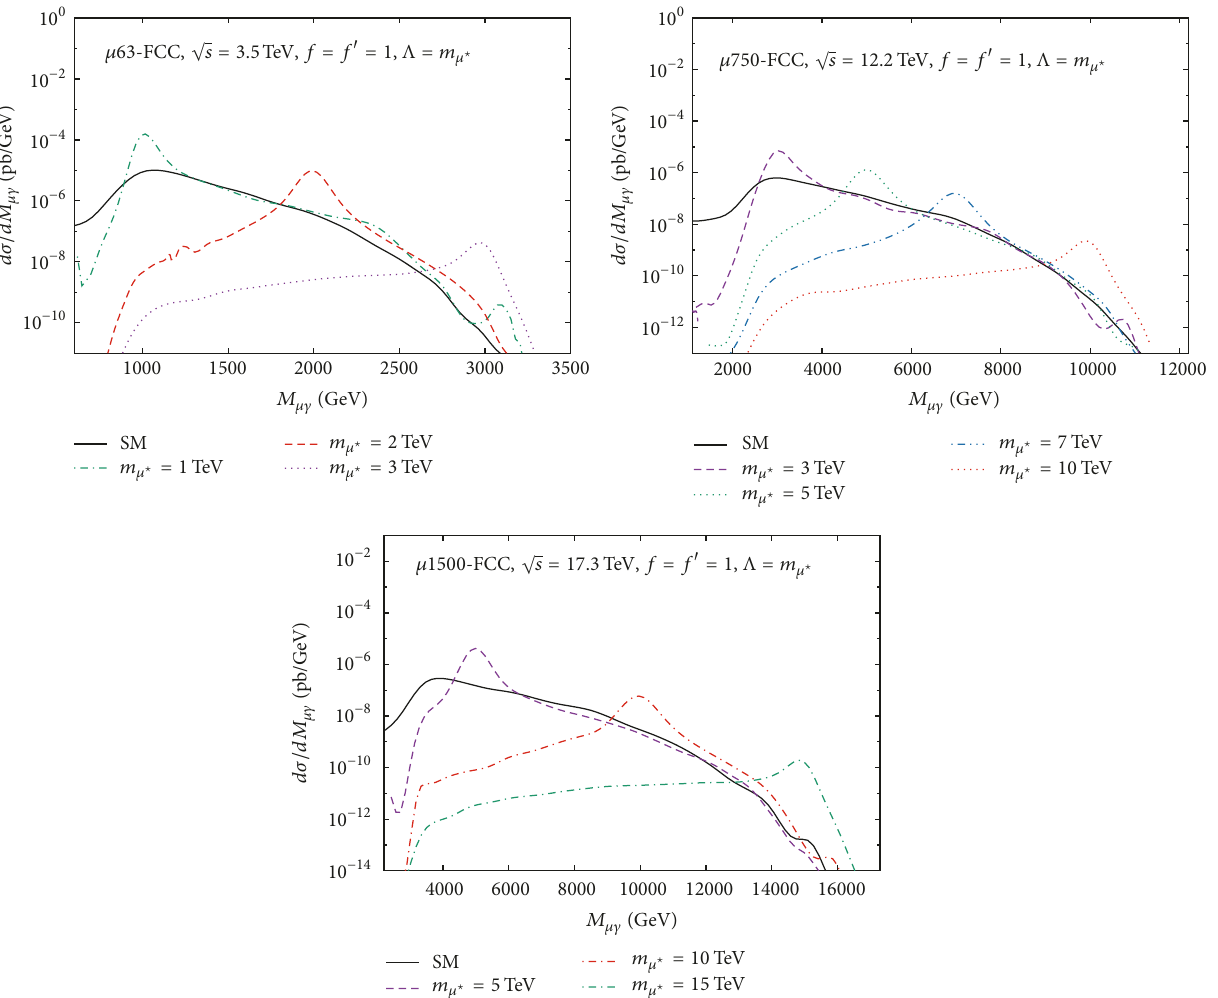
Figure 10: Invariant mass distributions of the 𝜇𝛾 system after the discovery cuts for 𝜇63 -FCC, 𝜇750 -FCC, and 𝜇1500 -FCC,